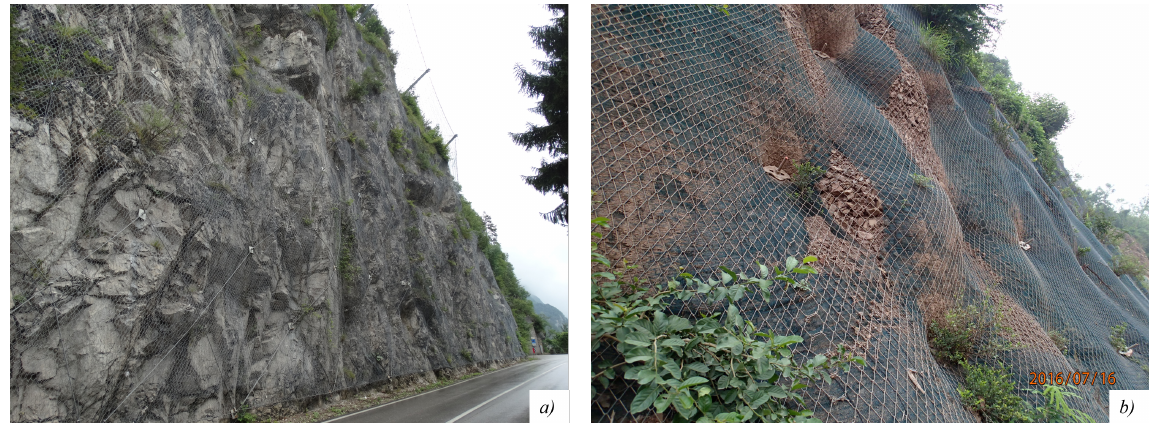
Figure 1. Reinforced drapery meshes with ( a ) retaining ropes, i.e., secured drapery, and with ( b ) spike plates, i.e., pinned